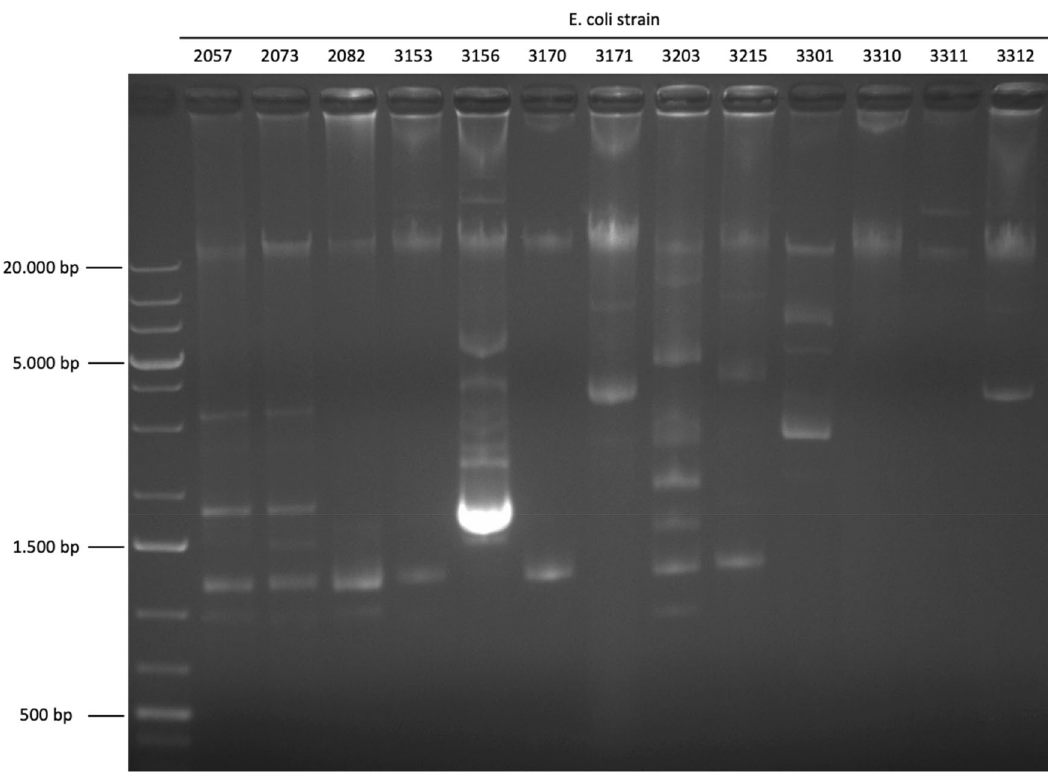
Figure 1. Gel photo showing different bands/plasmids isolated from different strains. Larger plasmids may have remained in or near the slots. Bands close in proximity of each other and with decreasing intensity suggest